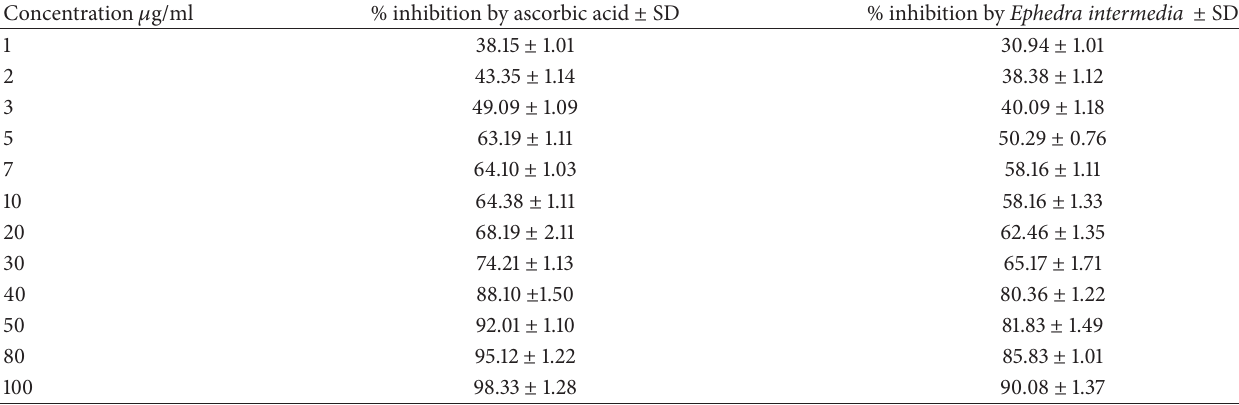
Table 4: Percentage inhibition activity for ascorbic acid and E. intermedia